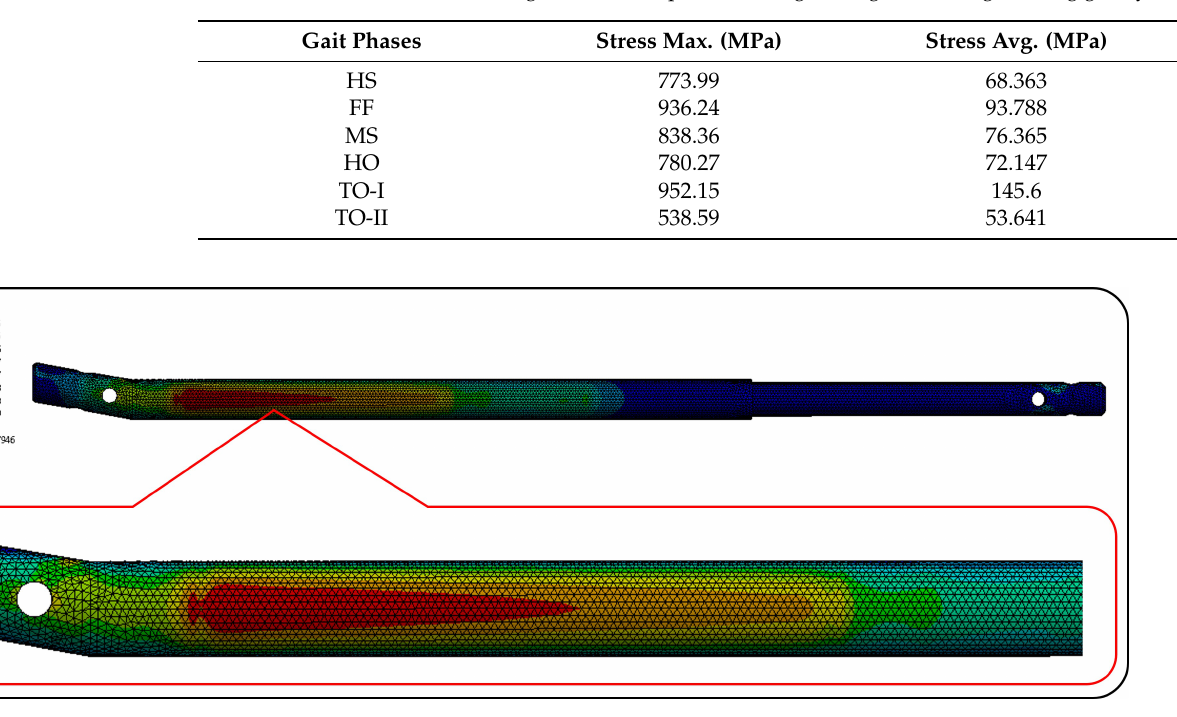
Table 4. The maximum and average stress on implantable lengthening nail during walking gait cycle.